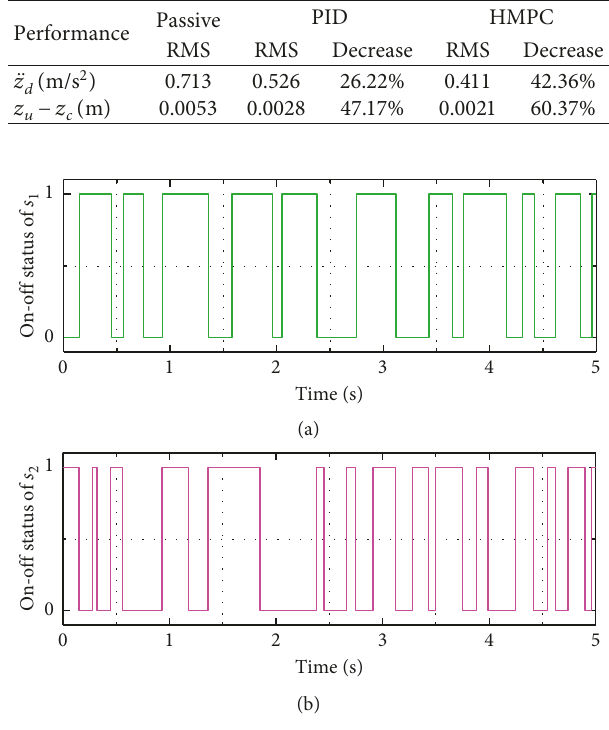
Figure 9: On-off status variations of the solenoid